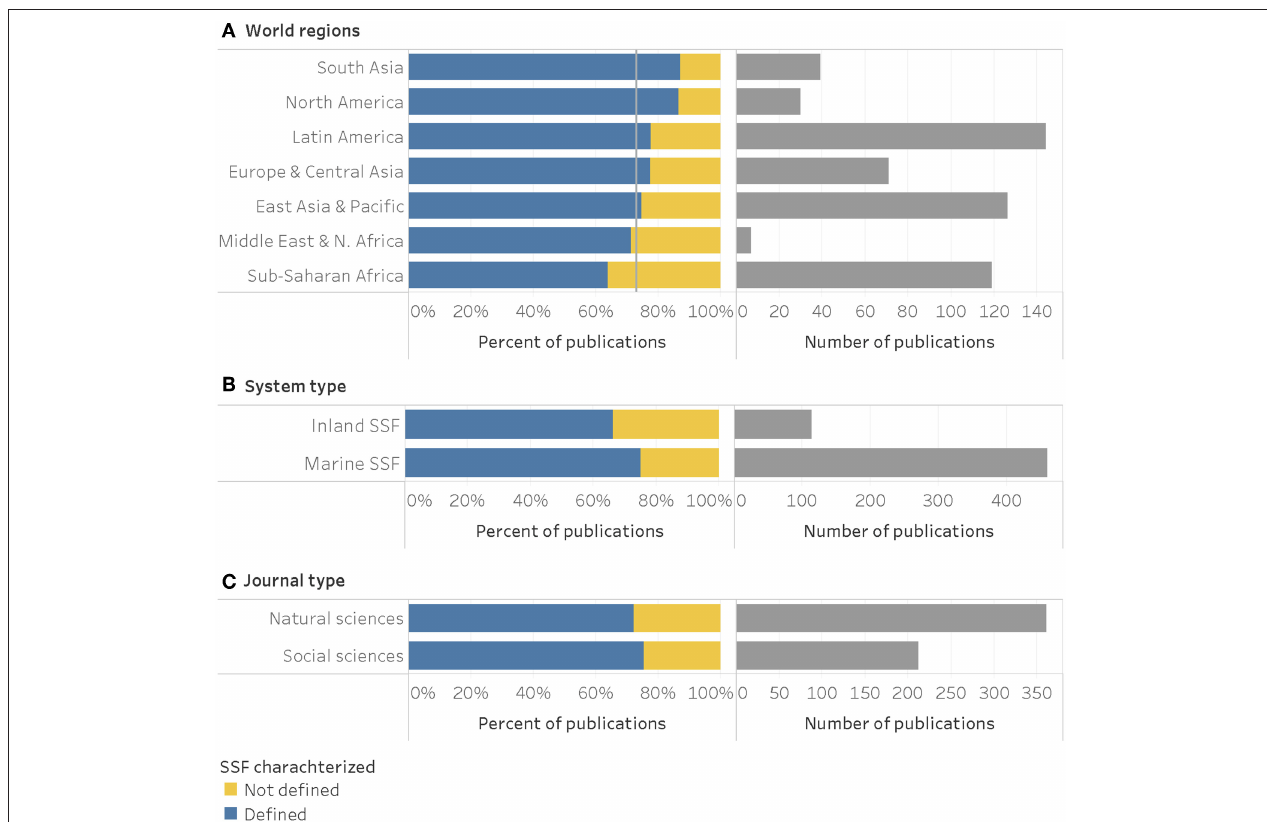
FIGURE 2 | Percentages of articles that defined small-scale fisheries by world regions (A) , aquatic system type (B) , and journal outlet (C) . The gray vertical line indicates the average (73%) for the overall sample.